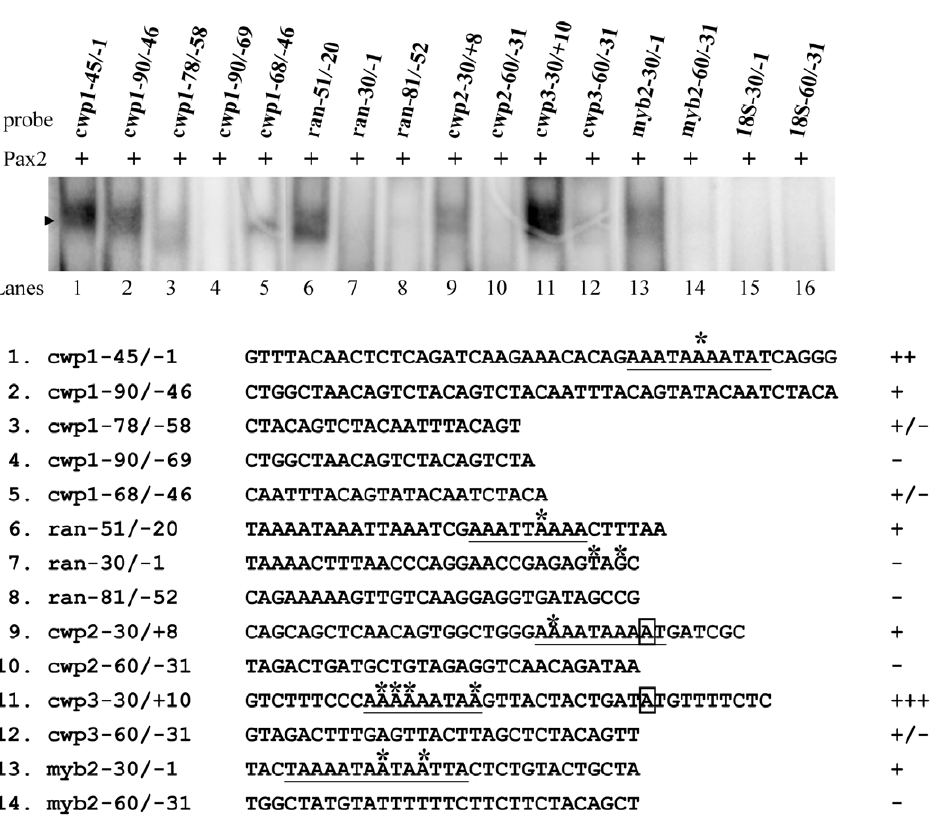
Figure 6. Detection of Pax2 binding sites in multiple promoters. Electrophoretic mobility shift assays were performed using purified Pax2 and various 32 P-end-lableled oligonucleotide probes as described. Components in the binding reaction mixtures are indicated above the lanes. The arrowhead indicates the shifted complex. The transcription start sites of the cwp2 , cwp3 , and myb2 genes determined from 24-h encysting cells are indicated by asterisks [12], [14]. The transcription start sites of the ran gene determined from vegetative cells are indicated by asterisks [26]. The AT- rich Inr elements spanning the transcription start sites are underlined. The translation start sites of the cwp2 and cwp3 genes are framed. ‘‘18S’’ represents 18S ribosomal RNA. ‘‘ + ’’, ‘‘ + / 2 ’’, and ‘‘ 2 ’’ represent moderate binding, weak binding, and no binding, respectively. ‘‘ +++ ’’ and ‘‘ ++ ’’ represent strong binding.